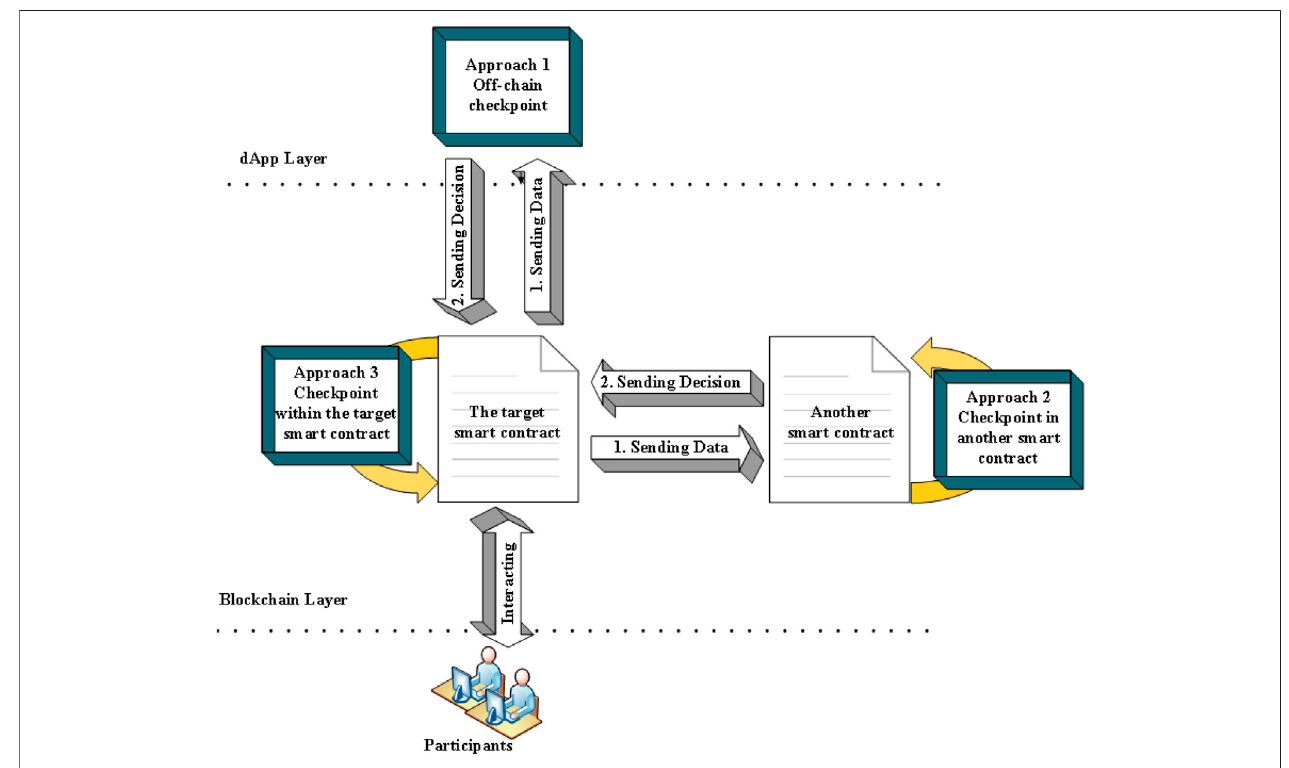
FIGURE 2 | Three approaches to implementing the architecture of the